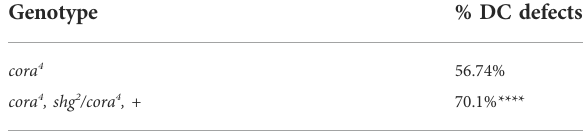
TABLE 1 Quanti fi cation of DC defects in cuticle preparations of cora 4 and cora 4 , shg 2 /cora 4 , +